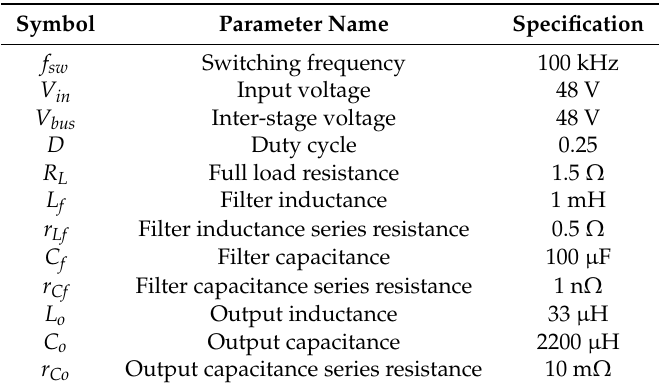
Table 1. Circuit